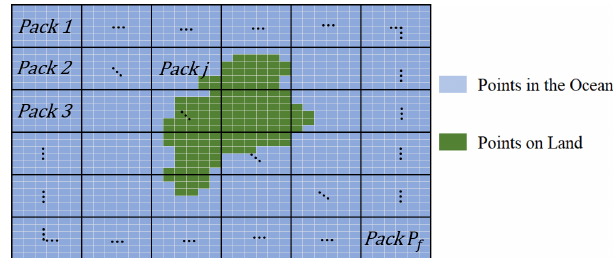
Figure 2. Illustration of the j th pack with its valid neighbors de- noted by a yellow highlight. In this example, it is evident that px is equal to 32 (number of pack points in the ocean) and dx is equal to 54 ( px plus the number of neighbors). It is also evident that n pack and m pack are both equal to 6 in this case.